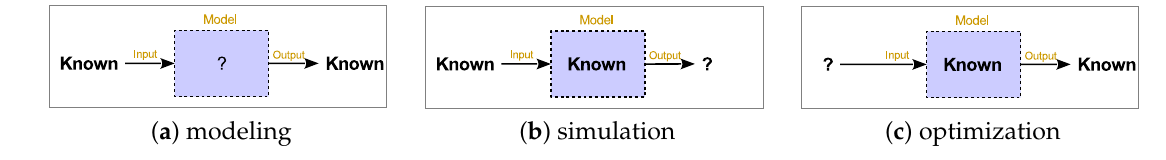
Figure 1. “black box” models for real-life problems.